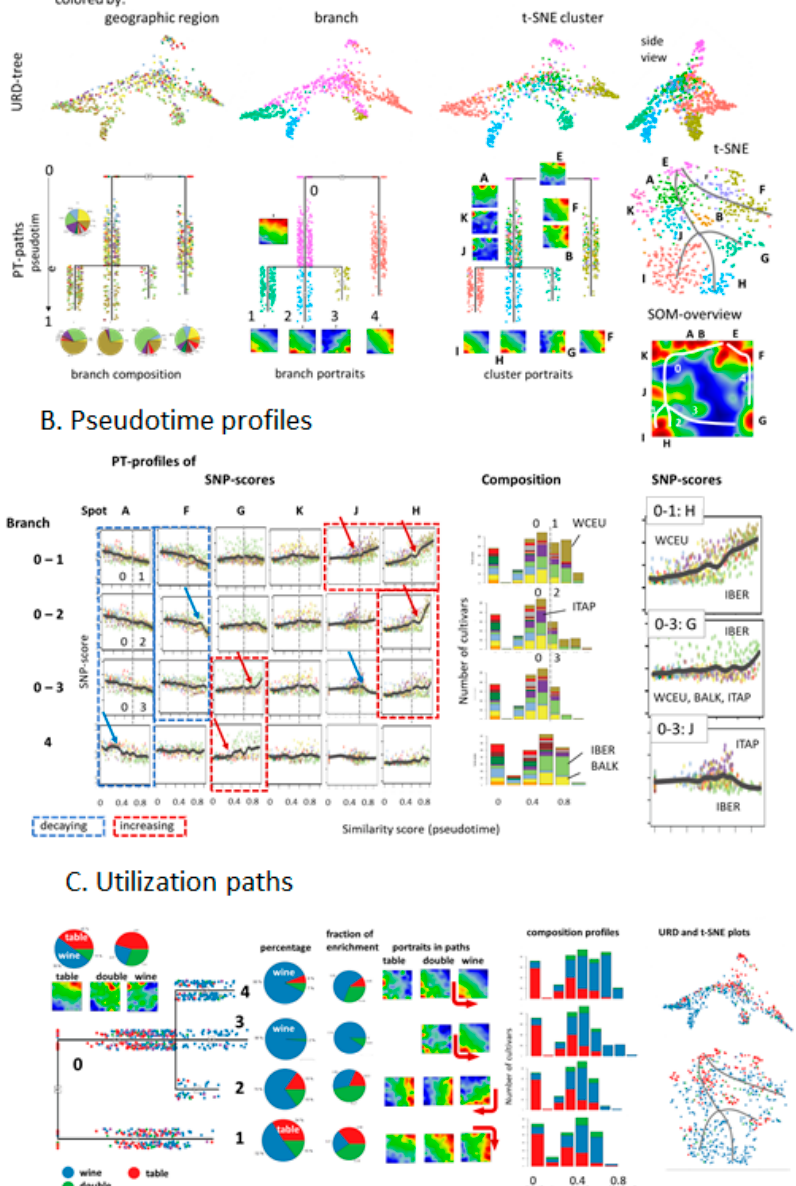
Figure 6. Multibranched pseudotime analysis: ( A ) Similarity paths using URD [26] reveal a ‘Kraken’ like distribution of vine cultivars which is described by four ‘tentacles’ as pseudotime branches. They accumulate cultivars preferentially from WCEU and IBER (see pie diagrams), respectively. t-SNE clustering provides ten clusters labelled by the most prominent SNP-spot expressed in each of them (right part). The grey and white curves visualize the paths of cultivar similarities in the t-SNE accession- and SOM SNP-space, respectively. ( B ) Pseudotime analysis reveals increasing (marked by red dashed rectangles) and decaying (blue rectangles) courses, indicating, e.g., accumulation or depletion of WCEU cultivar features and accessions at later PT values. Arrows indicate points of increasing (red) and decreasing (blue) slopes. Composition of the geographic origin of the cultivars is shown as barplot (middle). Enlarged SNP-profiles, as shown in the right part of the figure, reveal details of cultivar distribution around the LOESS-fits (locally weighted scatterplot smoothing, black curves). ( C ) The utilization of grapes (wine, table, double wine and table) along the developmental paths indicates that wine usage appeared at later PT and along all branches compared with table